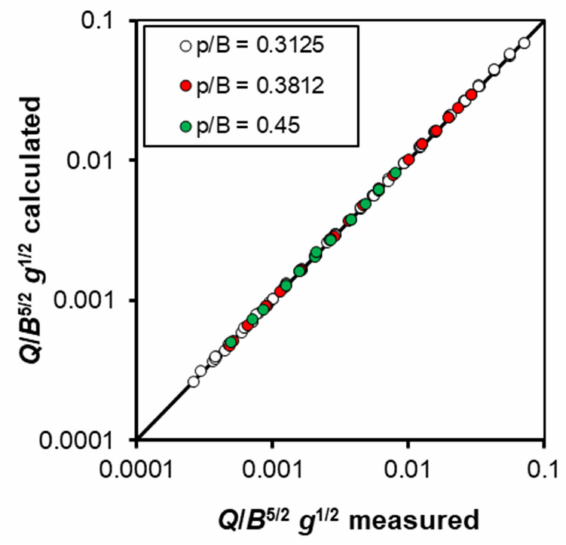
Figure 7. Comparison between the measured Q and (24) for the calibrating